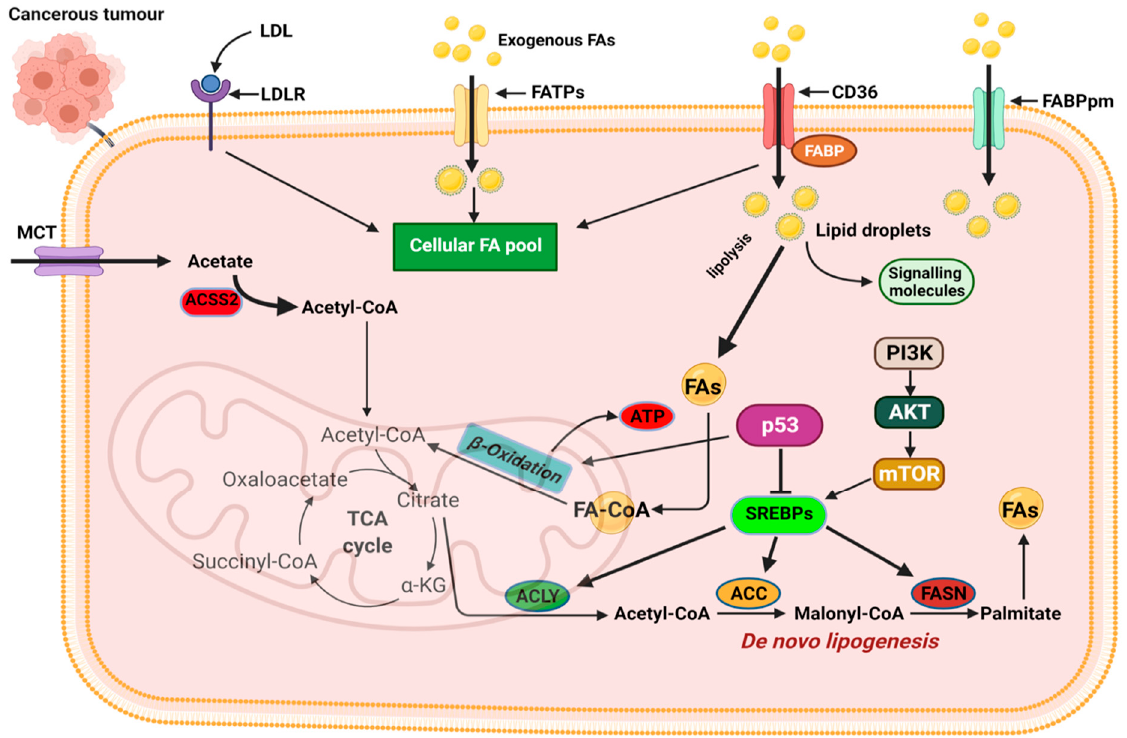
Figure 4. Mechanisms of fatty acid metabolic reprogramming. De novo lipogenesis and exogenous uptake of fatty acid both occur to sustain the altered lipid metabolism in cancer cells. The transporters CD36, FATPs, and FABPpm regulate exogenous fatty acid import. Increased CD36 and FATP expression is reported in various cancers. The oncogenic PI3K/Akt pathway is activated to regulate fatty acid metabolism. Activation of SREBPs is key in de novo lipogenesis and catabolism of imported fatty acids. MCT, monocarboxylate transporter; CD36, cluster of differentiation 36; FAs, fatty acids; FATPs, fatty acid transport proteins; FABPpm, fatty acid-binding protein; ACLY, ATP–citrate lyase; ACSS2, acyl-CoA synthetase short-chain family member 2; ACC, acetyl-CoA carboxylase; FASN, fatty acid synthase; SREBPs, sterol regulatory element-binding proteins. Figure created using BioRender.